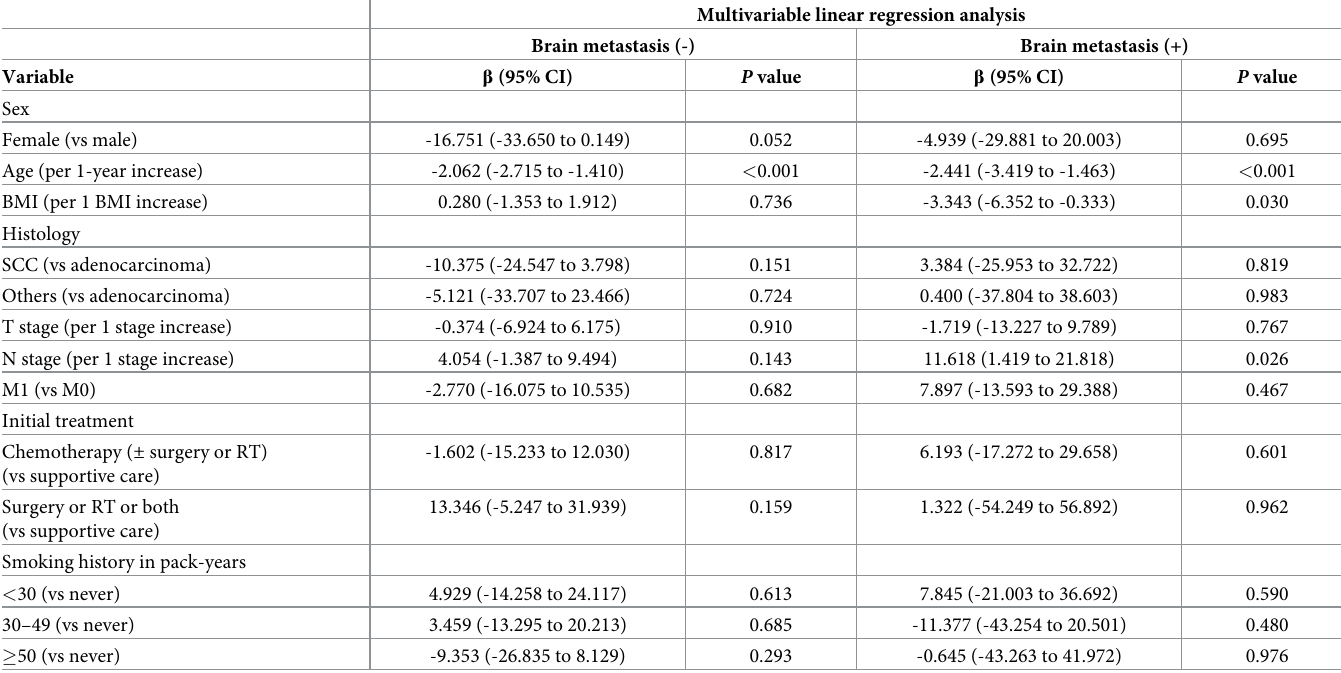
Table 2. Multivariable linear regression analysis of L1 HU value according to predictive factors for brain metastasis in patients with